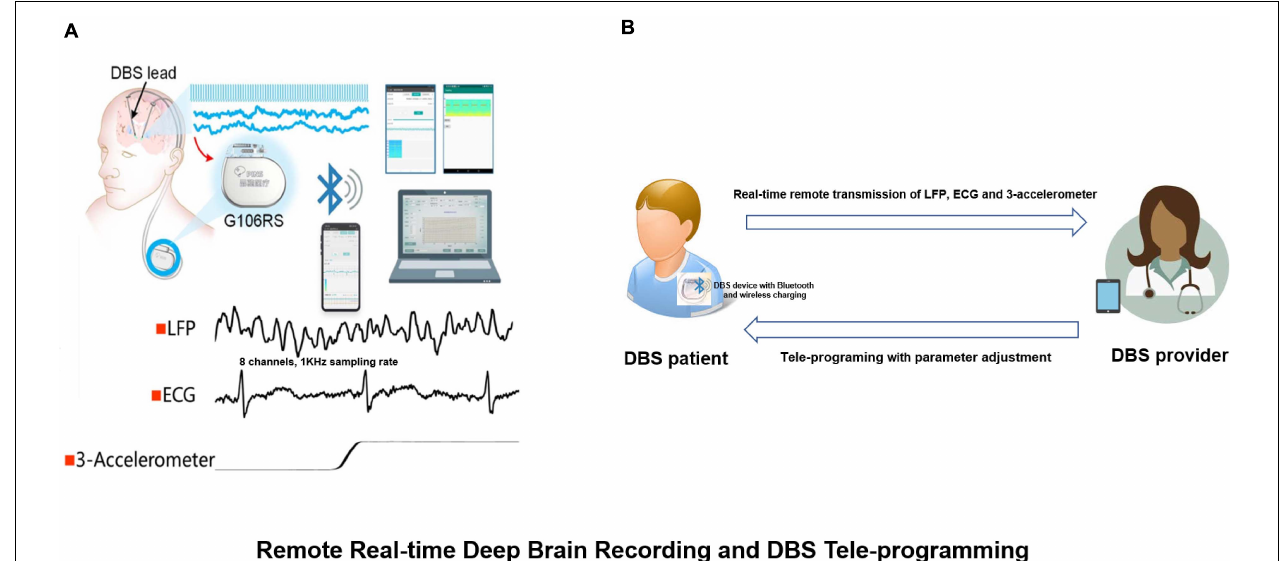
FIGURE 9 | Remote real-time deep brain recording and DBS tele-programming. (A) The G106RS system, a sensing-enabled DBS with Bluetooth connection, can monitor deep brain rhythms remotely. Specifically, it was capable of transmitting up to eight channels of local field potentials (LFPs) with 1,000 Hz sampling rate, one channel of electrocardiogram (ECG) and 3-D accelerometer signals; (B) DBS patient equipped with G106RS device with Bluetooth connection and wireless charging. A tele-programming DBS system can remotely adjust parameters via Bluetooth technology by the provider. The LFP, ECG and 3-D accelerometer signals can be transmitted remotely from the G106RS device to a data receiver accessed by the